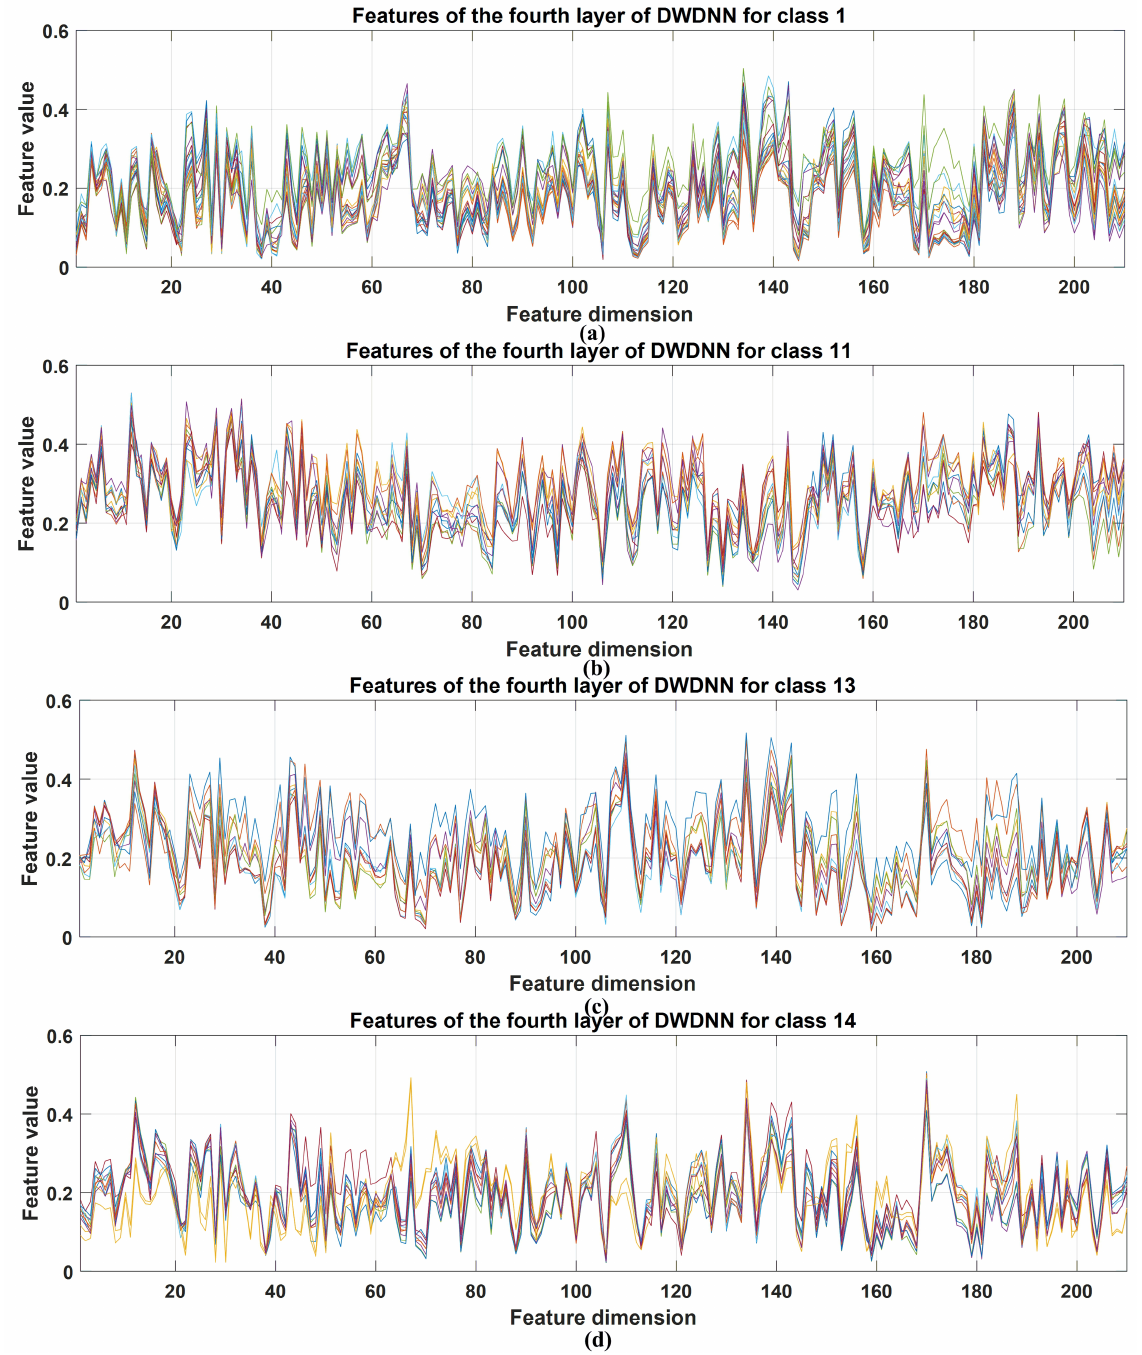
Figure 10. Stacked extracted features of the training instances from the last transform kernel layers of the DWDNN (10 EWSWS networks) with the Salinas dataset. ( a ) Extracted features for class 1. ( b ) Extracted features for class 11. ( c ) Extracted features for class 13. ( d ) Extracted features for class